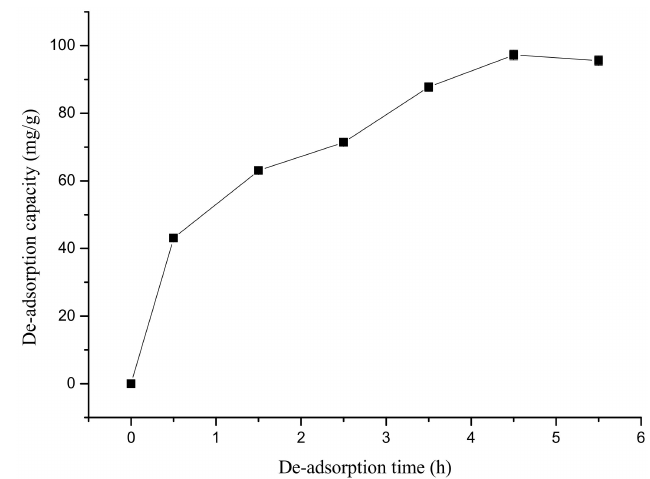
Figure 7. E ff ect of time on the de-adsorption capacity of amygdalin from the XDA-1 resin.